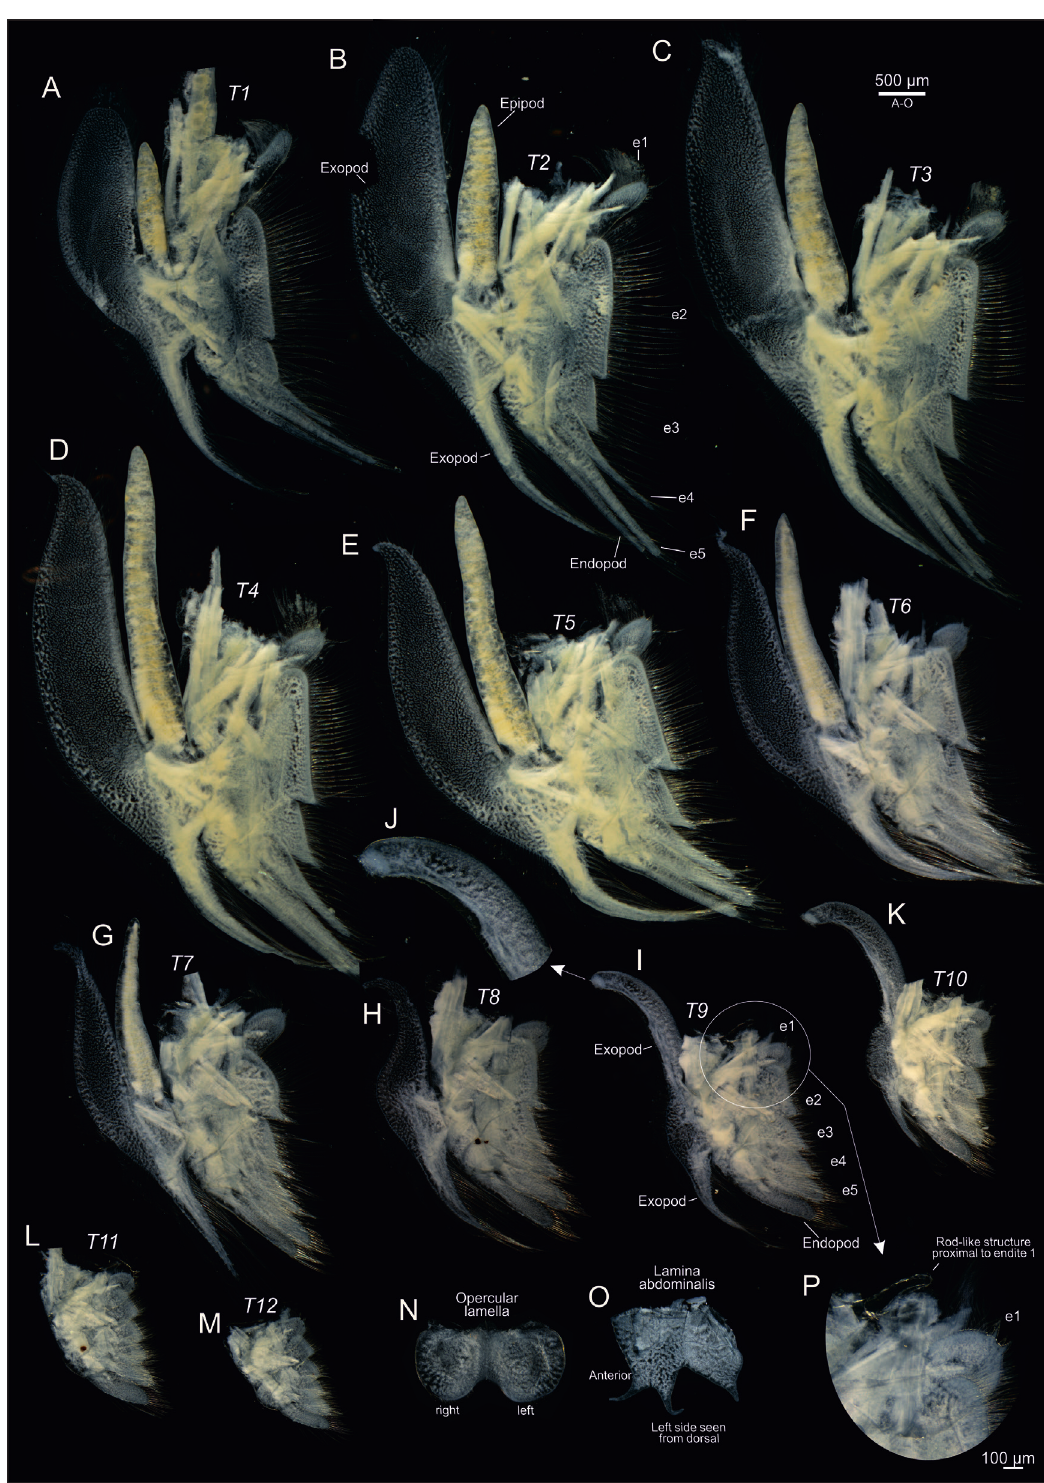
Fig. 7. Lynceus insularis sp. nov., ♀, light microscopy (allotype, ZMUC-CRU-4784), thoracopods of right side seen from anterior. A–I . Thoracopods 1–9. J . Close-up of dorsal part of exopod of thoraco- pod 9. K–M . Thoracopods 10–12. N . Opercular lamellae seen from anterior. O . Lamina abdominalis of left side seen from dorsal side. P . Close-up of rod-like structure proximal to endite 1. Abbreviations: e1–e5 = endites